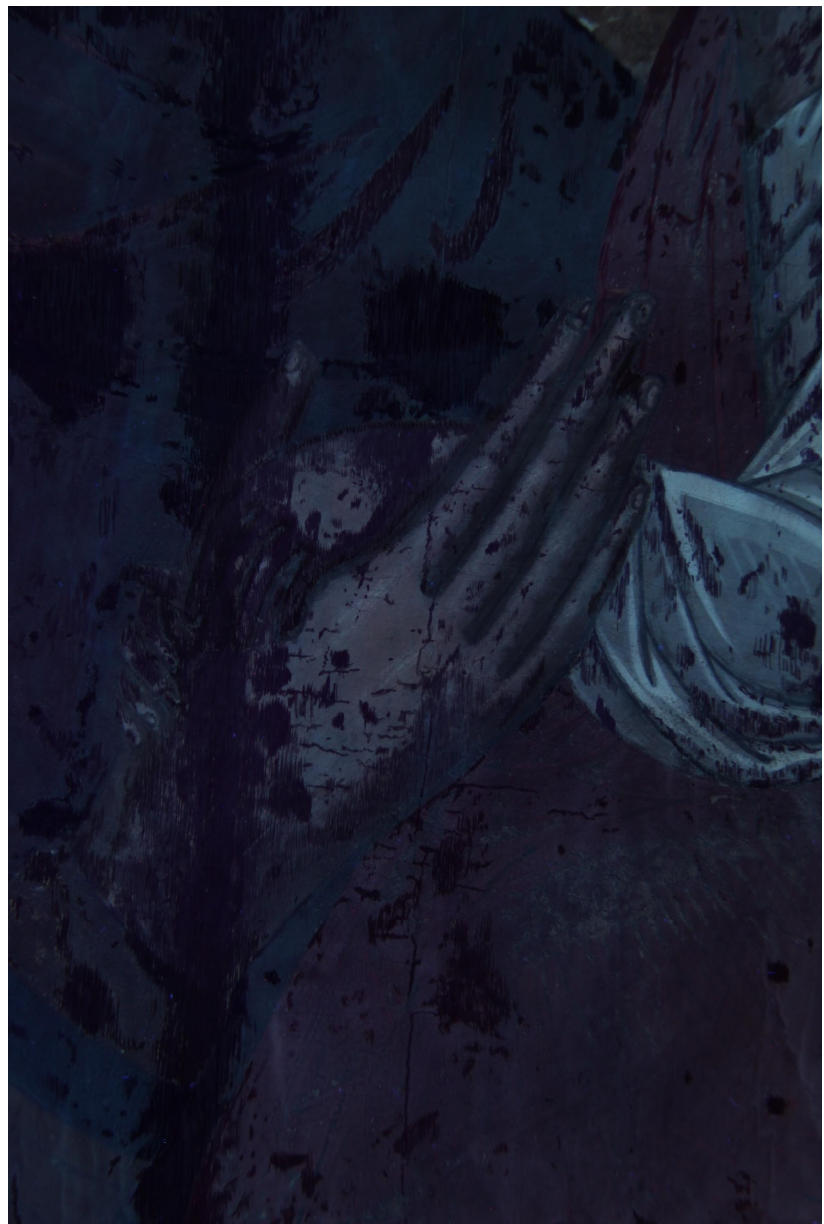
Figure 4. UV fluorescence: Detail, hands of the Madonna and Child Jesus, and numerous pictorial retouches can be observed.